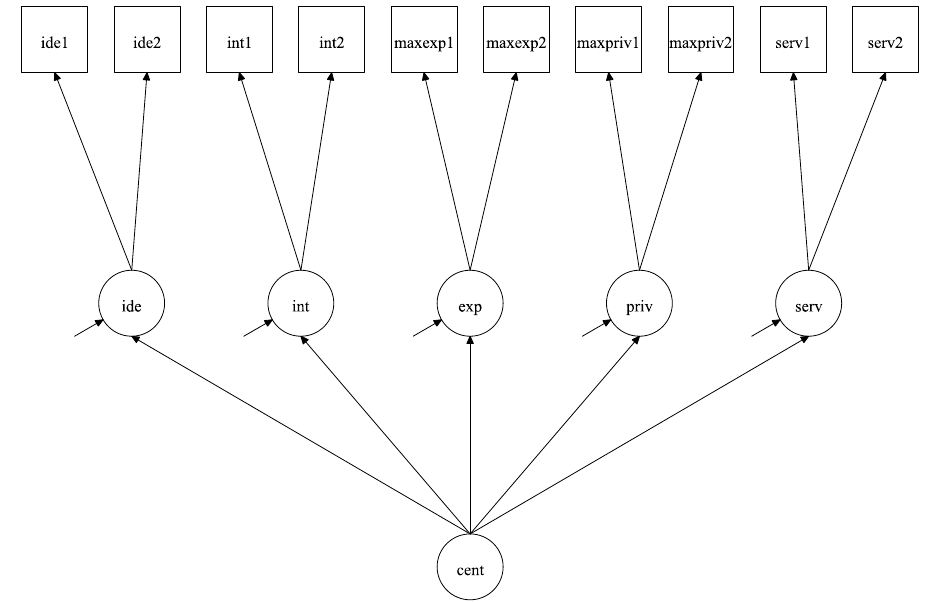
Figure 4. The confirmatory factor analysis model for the CRSi-14. int = intellect; ide = ideology; serv = public practice; priv = private practice; exp = experience; max = this prefix means that out of two items, only the one with the higher value for this core dimension is proceeded in the analysis. The number after the item name indicates the position of the item within the core dimension items. Squares depict manifest and circles latent variables. Residual arrows are not shown for the manifest variables. Residuals for the latent variables are shown as arrows starting in blank space.